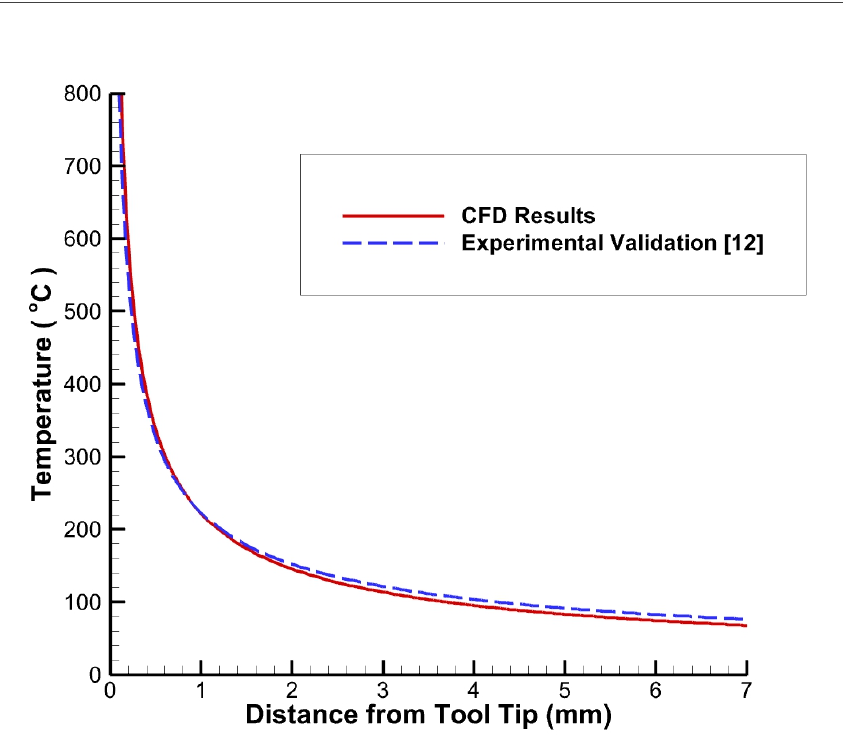
Nanomaterials 2022 , 12 , x FOR PEER REVIEW Figure 5. Numerical validation with benchmark experimental results [12]. Figure 5. Numerical validation with benchmark experimental results [12].